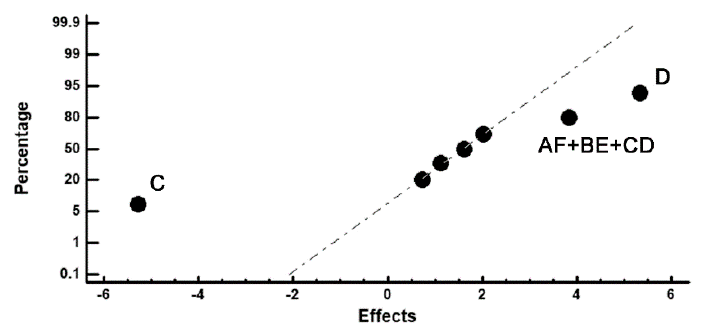
Figure 2. Representation of the effects on a normal probability plot. Those factors with a significant effect on resistance to erosive wear are highlighted.